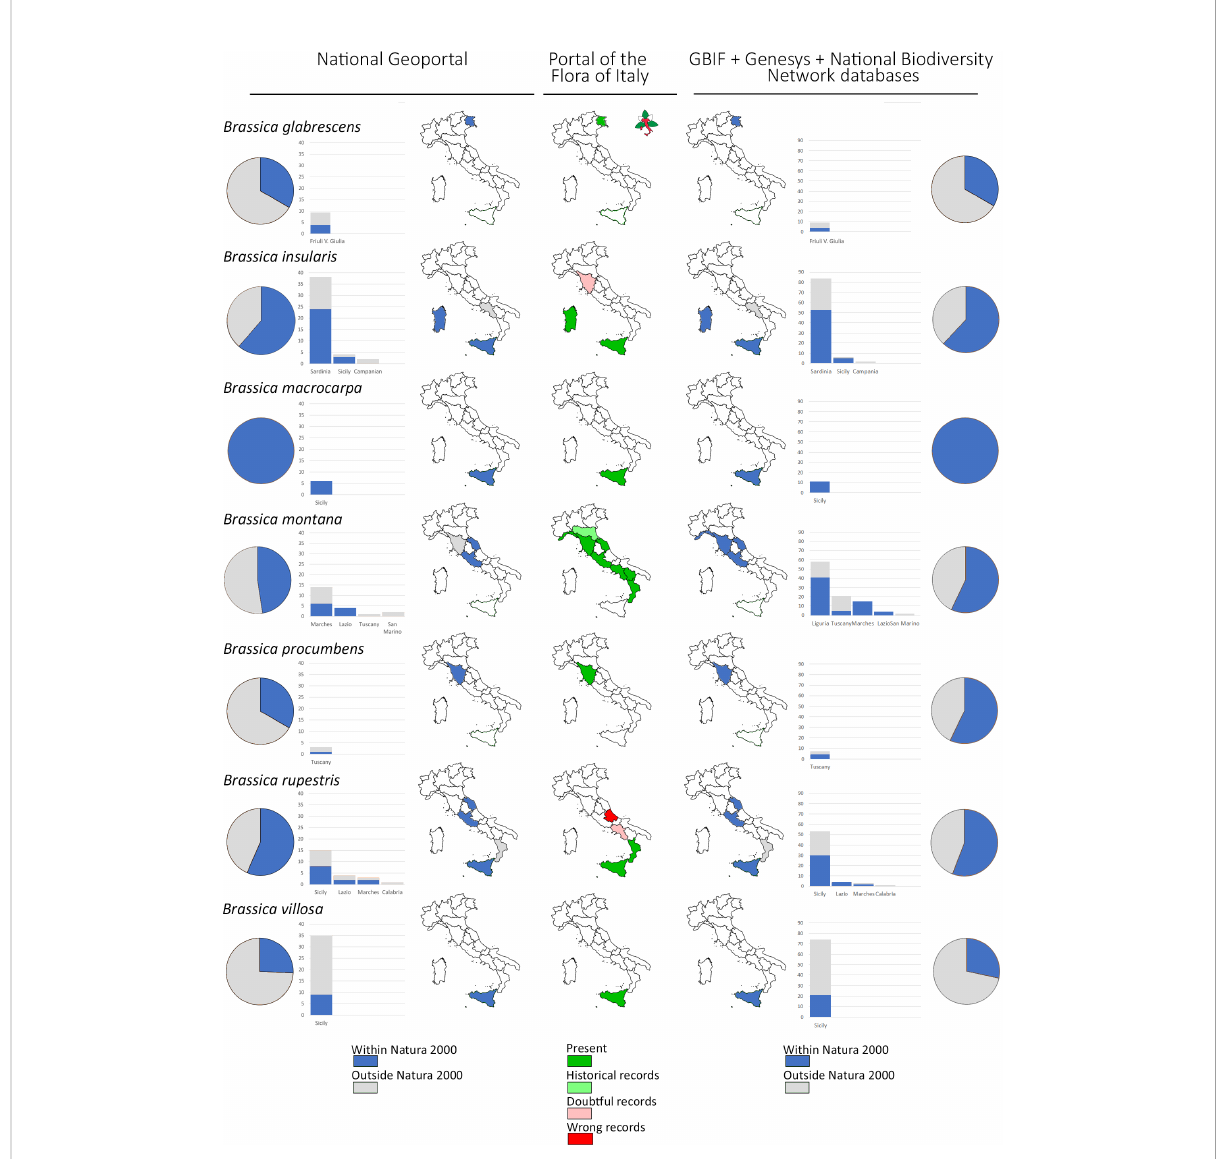
FIGURE 3 For each species in ‘ A ’ category of the genus Brassica : pie graph representation of the proportion of populations occurring within (blue) and outside (light grey) sites of the Natura 2000 network with histograms and graphical representation of the distribution in the different Italian Regions according to data in the ‘ National Geoportal ’ (left) and in GBIF + Genesys + National Biodiversity Network databases (right). Occurrences of each species in the different Italian Regions according to the ‘ Portal of the Flora of Italy ’ are also reported (center) with the corresponding colour